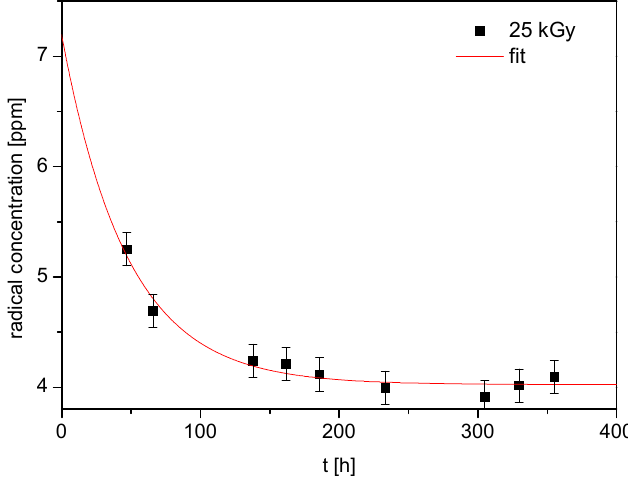
Figure 4. Concentration of free radicals vs. time after sterilisation (irradiation dose 25 kGy).